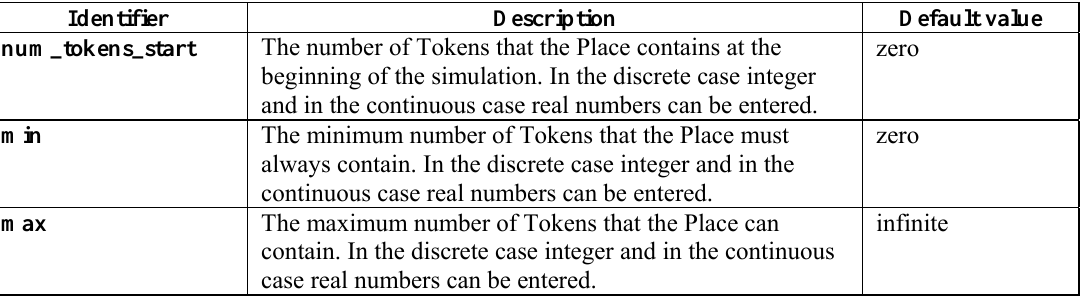
Table 1: Parameters of both Places (discrete and continuous).